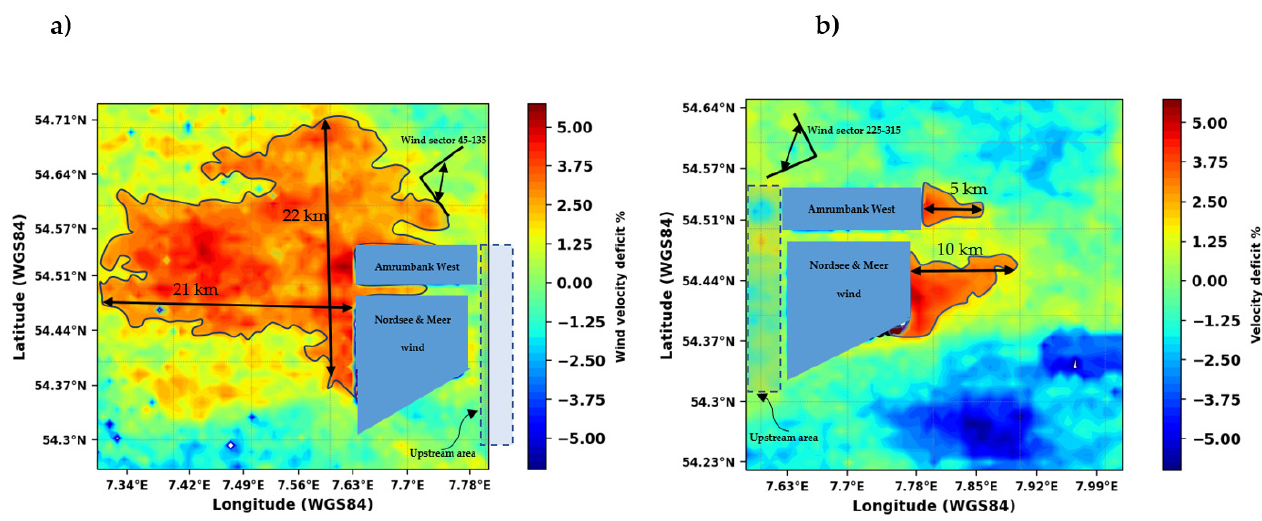
Figure 11. Map of the velocity deficit ( 𝛥𝑈) around the Nordsee cluster calculated from the SAR wind maps in Table 3 for ( a ) easterly winds and ( b ) westerly winds at 10 m m.s.l. The contour lines show the area where the 𝛥𝑈 exceeds 3%. The dashed rectangle shows the area used for calculating the upstream wind velocity.